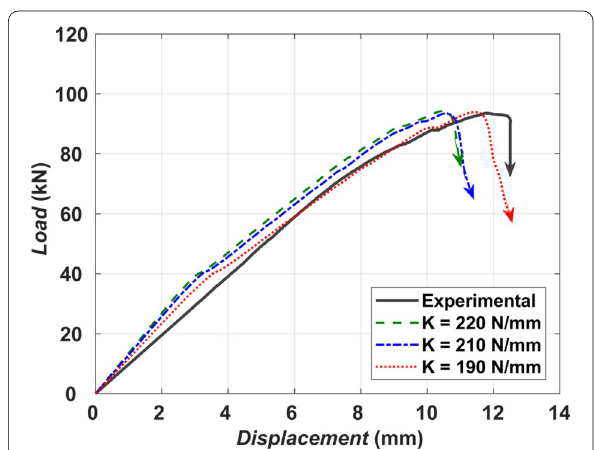
Fig. 18 Load–displacement response for the numerical model with different values of